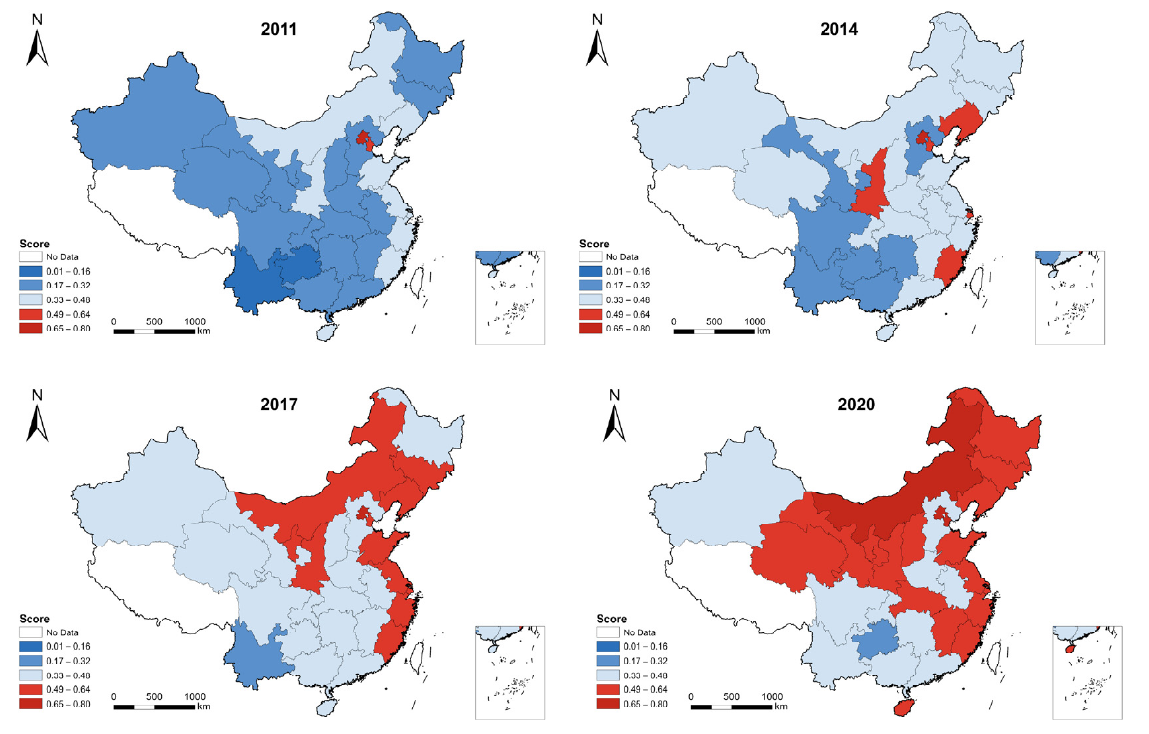
Figure 5. Spatial distribution of well-being scores in 2011, 2014, 2017, and 2020.